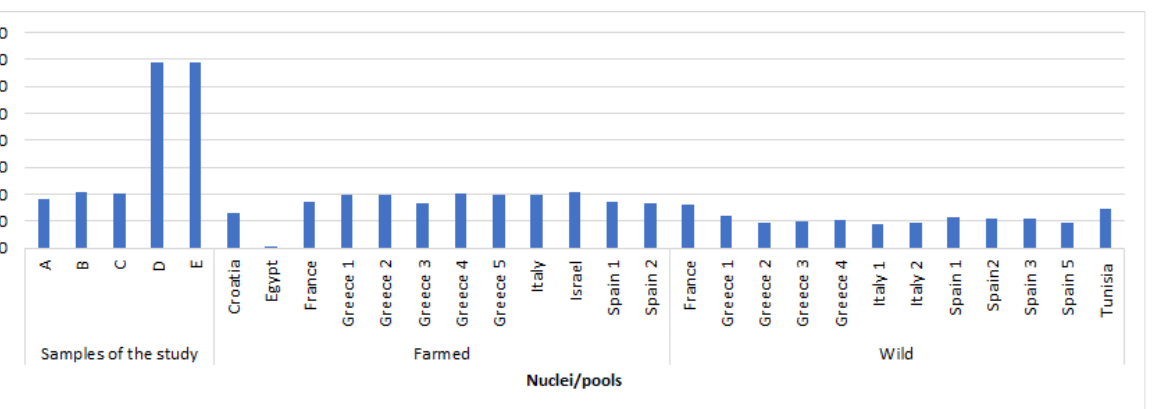
These differences can also be seen when investigating the percentage of fixed alleles within each group (Figure 2). DNA pools A1, A2, and A3 had a similar percentage that ranged from 19 to 26%, in line with wild and farmed pools. The DNA pools with the highest percentage of monomorphic alleles were DNA pools B and C, both with 69% and an overlapping of SNPs of 68%, which confirms the genetic diversity of these pools underlined by the PCA analysis. The low genetic diversity observed in these nuclei may indicate a higher level of inbreeding than in nucleus A [36].